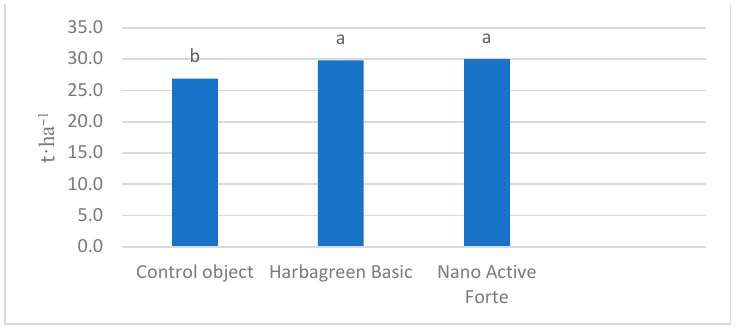
Figure 7. The effect of multi-component nanoparticle biological agents on potato tuber yield. a,b-mean values indicated by the same letters are not statistically significant at the 0.05 level by Tukey’s test.